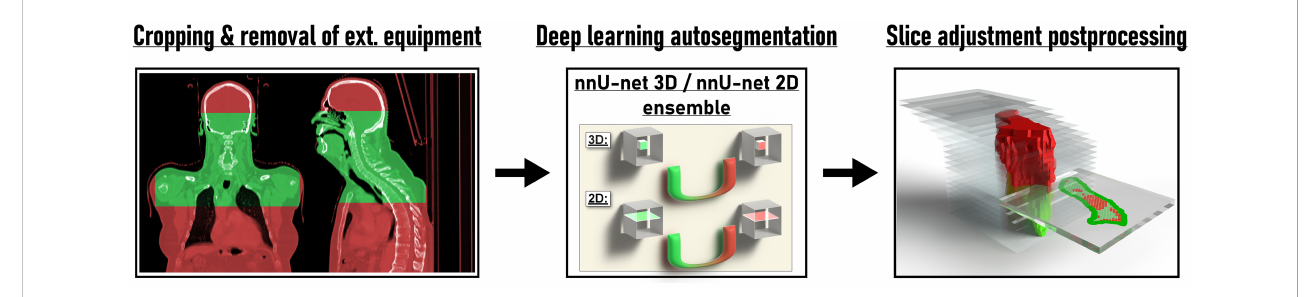
FIGURE 1 Overview of the proposed method for deep learning head and neck lymph node level autosegmentation (see text for